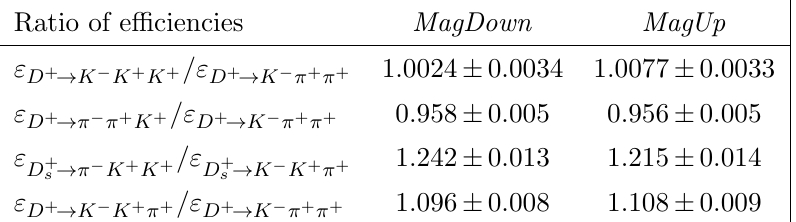
Table 2 . Ratios of average e(cid:14)ciencies for the full selection. The quoted uncertainty is due to the limited size of the simulated sample only (see section